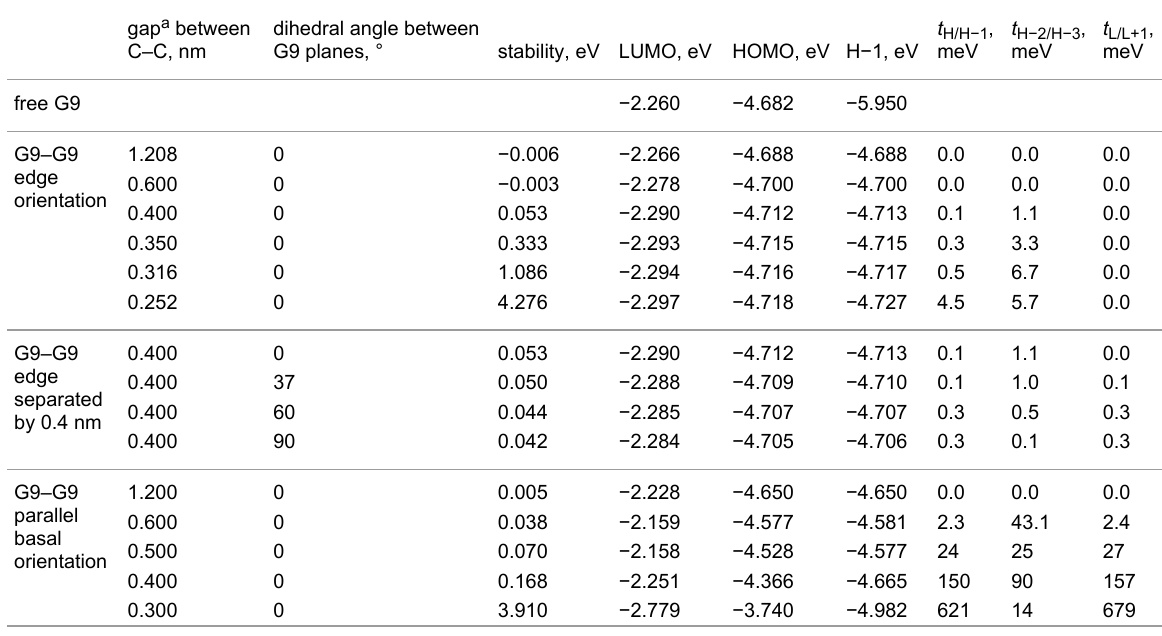
Table 2: Orbital energies and electronic coupling between G9 molecules. gap a between C–C,